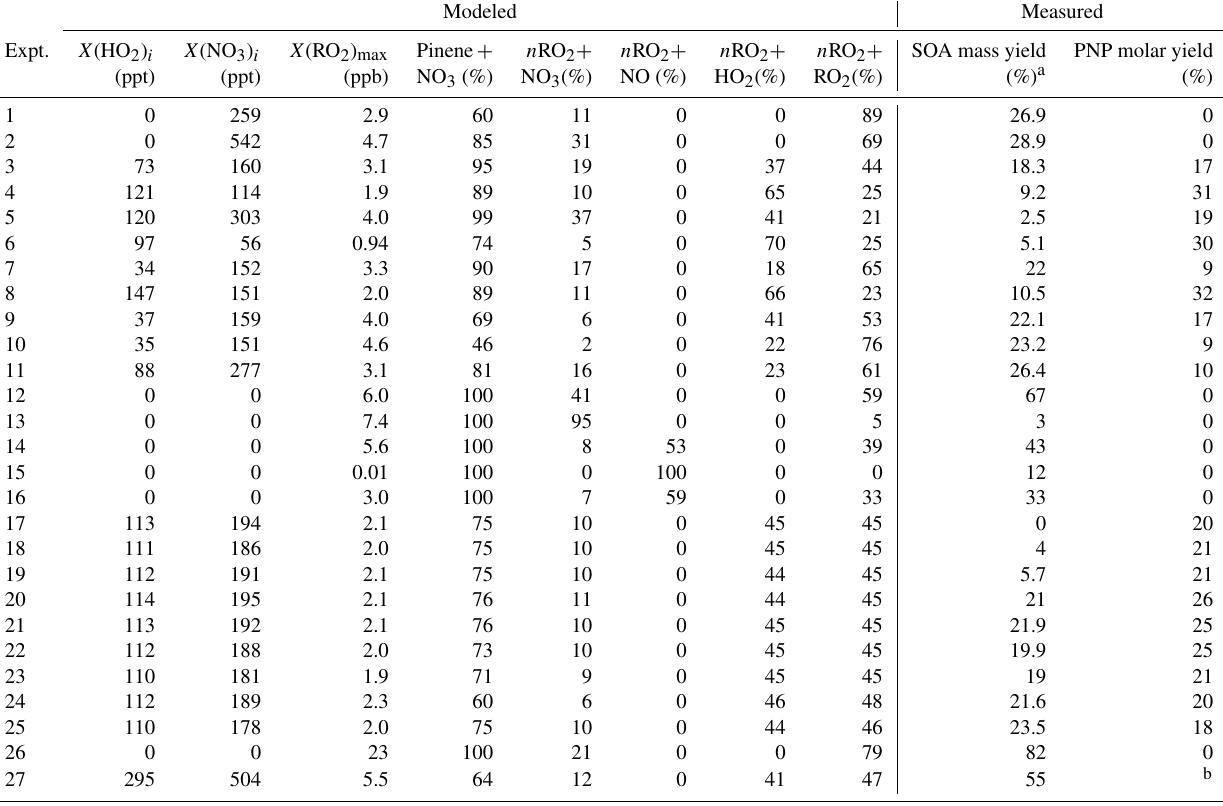
Table 2. Peroxy radical pathway contributions and measured experimental outcomes for experiments performed in this work.